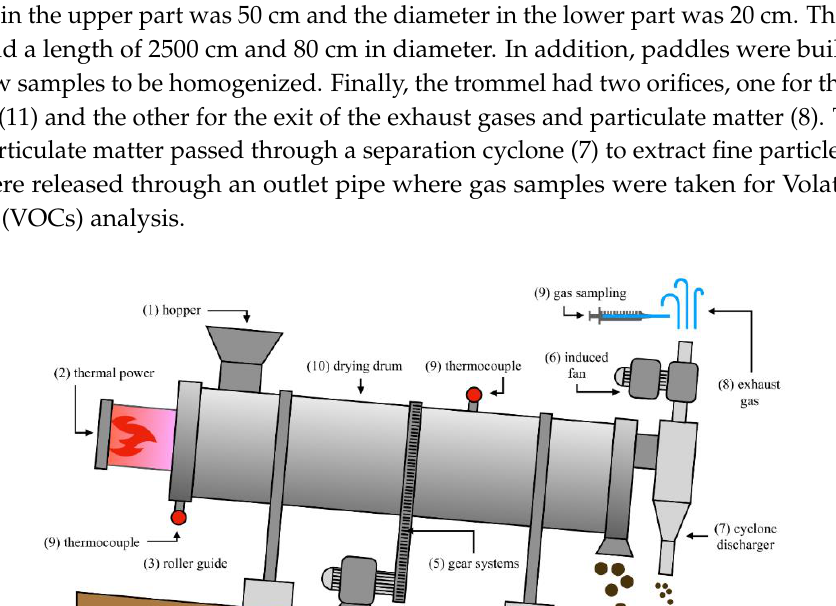
Figure 1. Biomass drying trommel. (1) hopper; (2) thermal power; (3) roller guide; (4) motor; (5) gear systems; (6) induced fan; (7) cyclone discharger; (8) exhaust gas; (9) thermocouple; (10) drying drum;